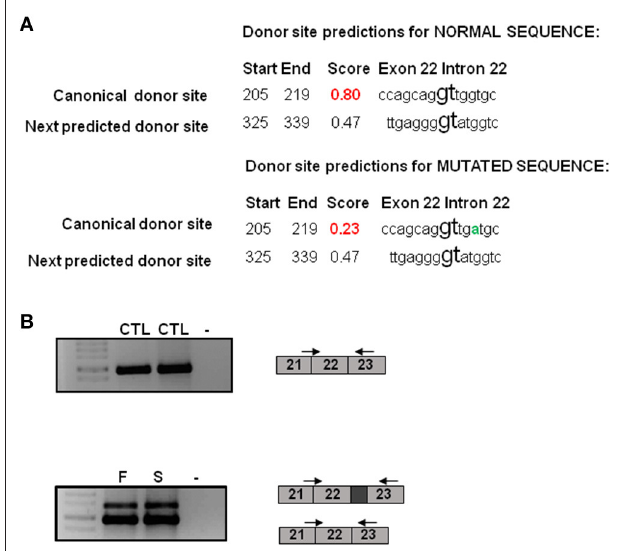
FIGURE 2 | Molecular characterization of the NSD1 variant. (A) Bioinformatics analysis of the c.6463 + 5G > A variant. NNsplice program predicts that the score for the donor splice site changes from a high value of 0.80 in the wild type sequence to a low value of 0.23 in the mutated sequence. The next donor splice site in the mutated sequence in the intron 22 is predicted to be 120 bp far from the first one. The variant change is represented in green. (B) RT-PCR analysis reveals an additional band in the father and the son in comparison to controls. This band is 120 bp longer than the other one. CTL, control; F, father; S, son.